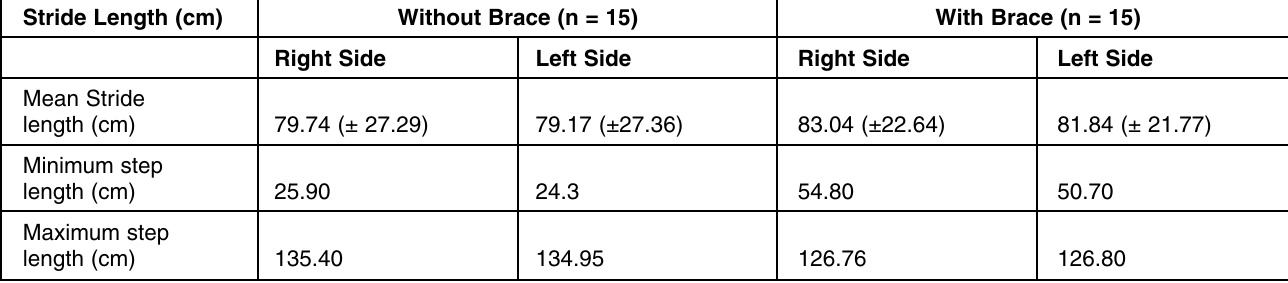
Table 2: Step length with and without FECK Brace